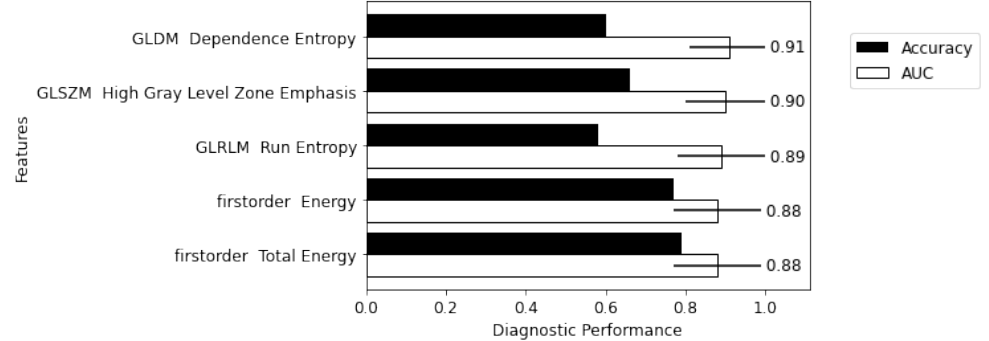
Figure 6. Diagnostic utility of the five highest performing individual radiomic features—performance ranked by validation AUC with a balanced accuracy above 50%.